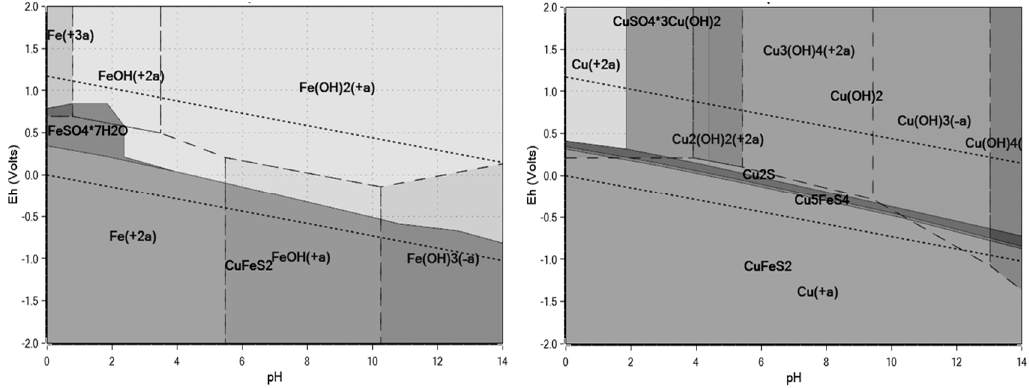
Figure 2. Cu-Fe-S Pourbaix diagrams.